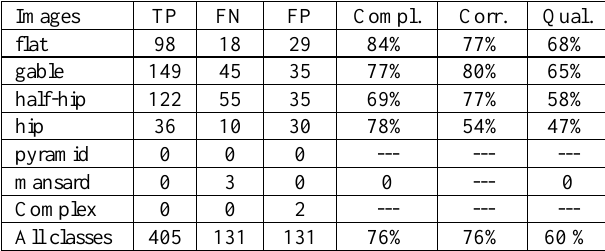
Table 2. Quantitative evaluation results for test data using